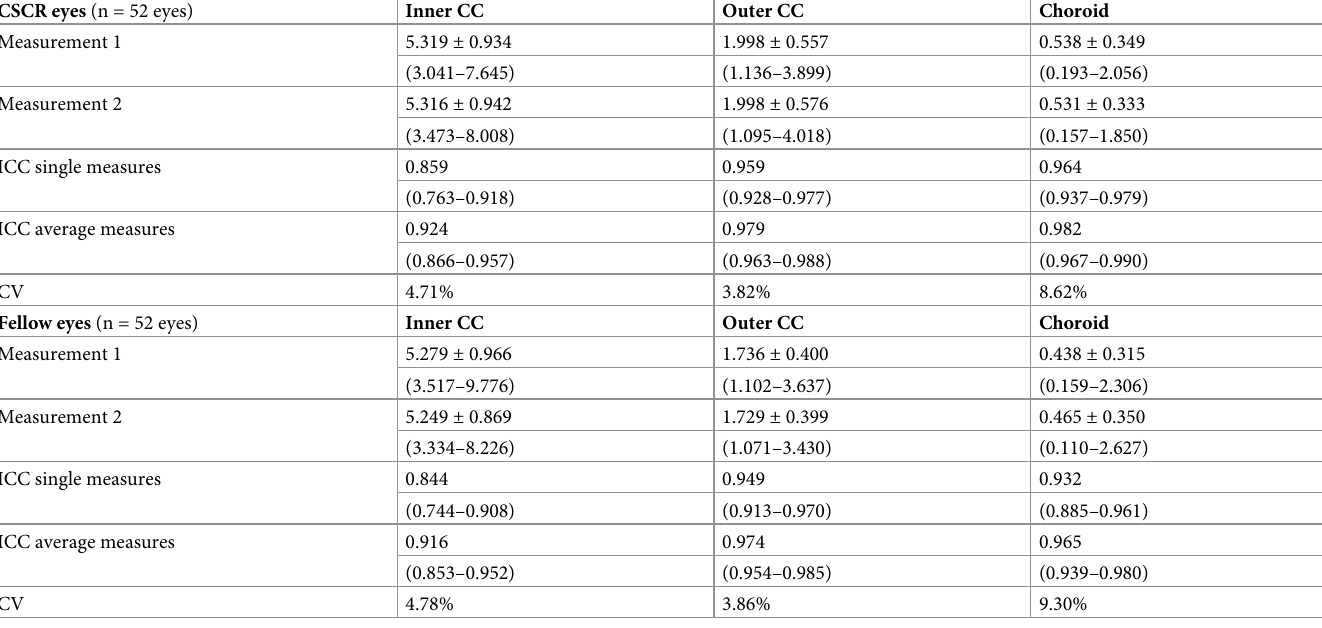
Table 1. Absolute values and repeatability of flow signal voids (FSV) area ( μ m 2 ) in the different groups and slabs studied by swept-source optical coherence tomog- raphy